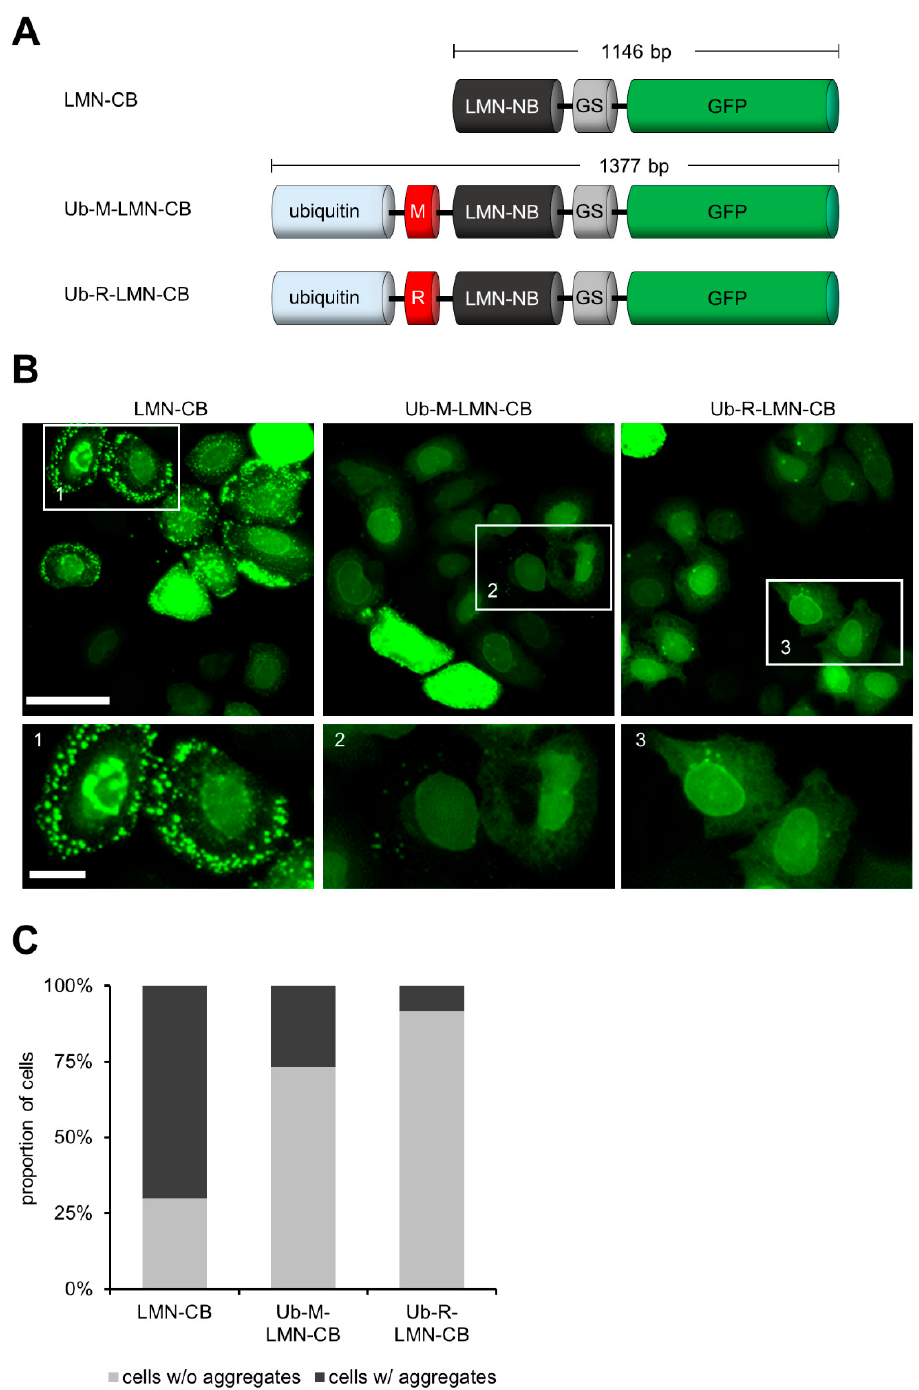
Figure 2. N-terminal fusion to ubiquitin reduces aggregation of the LMN-CB upon expression in HeLa cells. ( A ) Schematic illustration of different expression constructs: one encoding for an unmodified LMN-CB and two constructs encoding the CB as ubiquitin fusion displaying either methionine (Ub-M-LMN-CB) or arginine (Ub-R-LMN-CB) as the N-terminal amino acid. ( B ) Representative fluorescence images of HeLa cells transiently expressing either LMN-CB, Ub-M-LMN-CB or Ub-R-LMN-CB. Fluorescence images were acquired 24 h post transfection, scale bars images: 50 µ m, insets: 10 µ M. ( C ) Quantification of HeLa cells showing aggregates upon transient expression of the indicated LMN-CB variants. Number of analysed cells: LMN-CB: 198; Ub-M-LMN-CB: 142; Ub-R-LMN-CB: